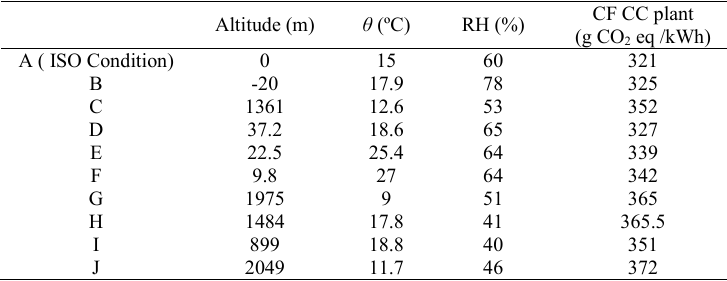
Table 9: Third group of Scenarios investigating internal consumption on Carbon Footprint Plant type